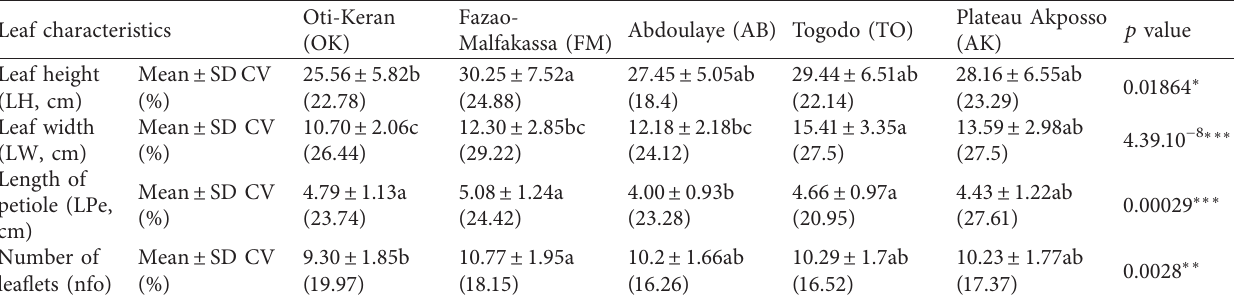
Figure 8: Distribution of trees’ leaf characteristics at the five sites. Table 7: Mean values and coefficients of variation (CV in percentage) of leaf